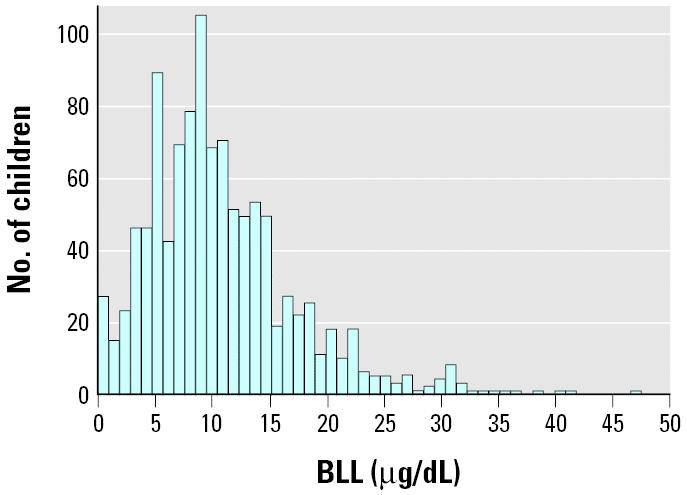
BLLs (n = 1,078) in children < 3 years of age in Mumbai and Delhi, India.